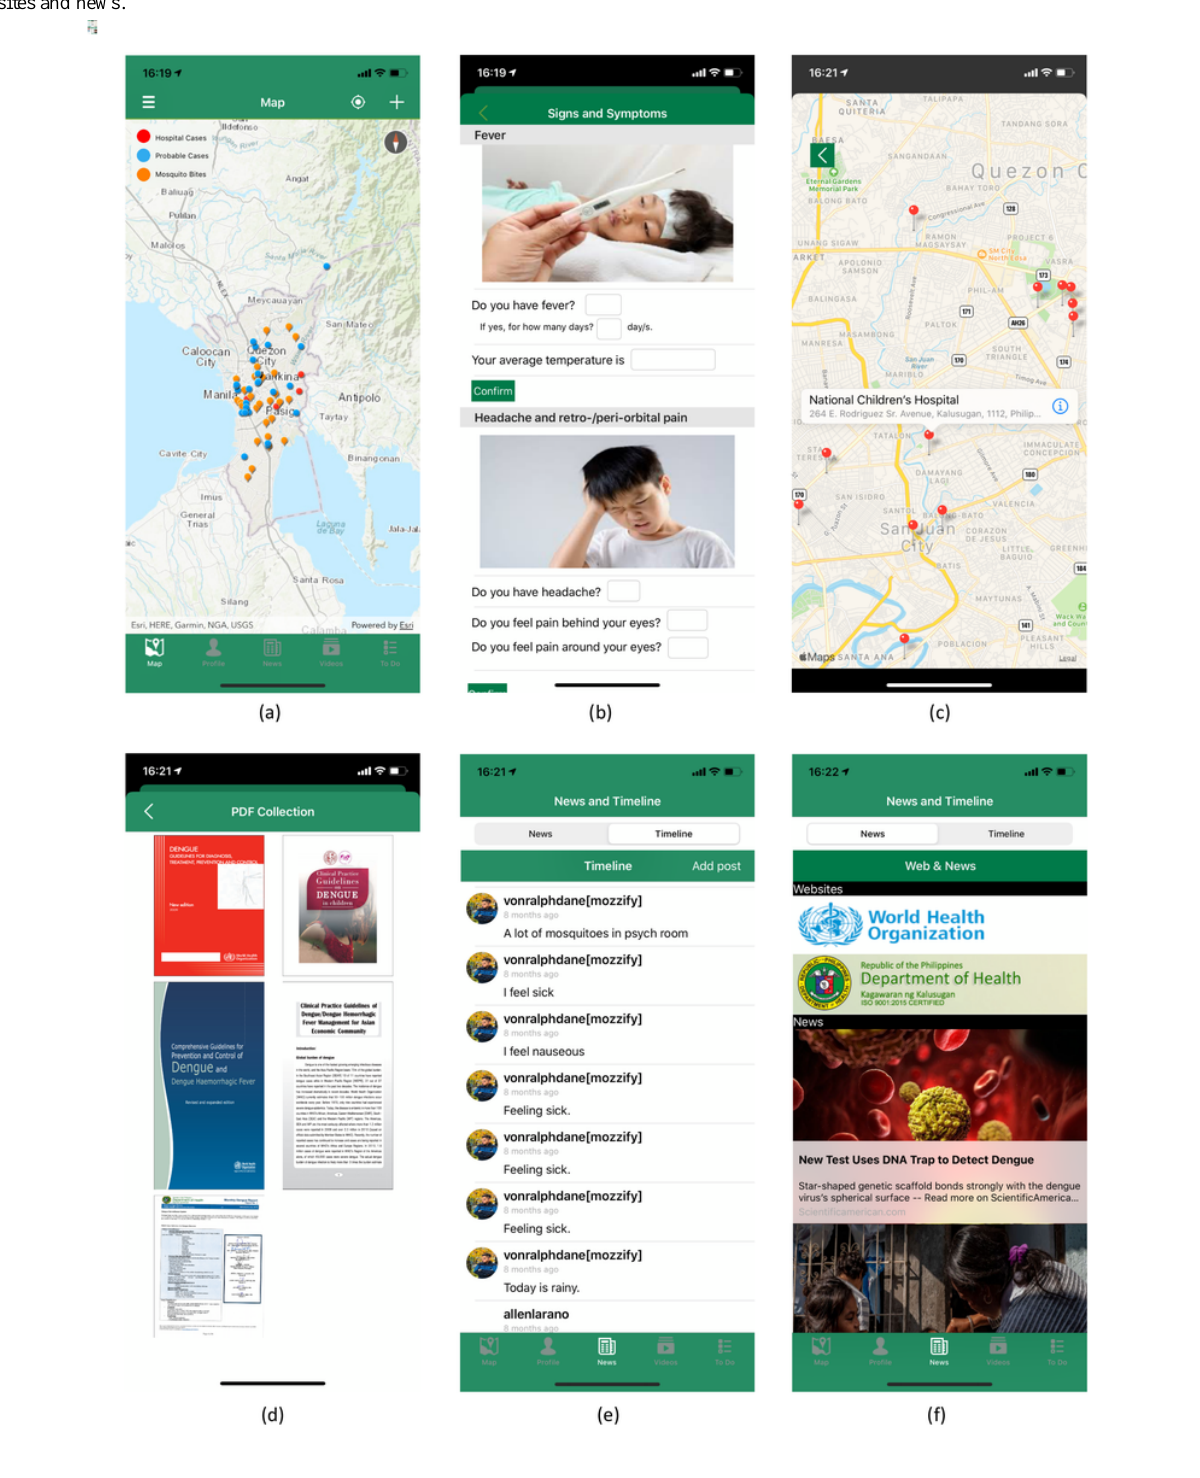
Figure 1. Screenshots of the Mozzify app: (a) Dengue fever cases and mosquito bite reporting and mapping, (b) symptoms checker, (c) hospital directions, (d) within-app local and international PDF collection on Dengue fever, (e) chat forum (timeline), (f) local and international health agency websites and